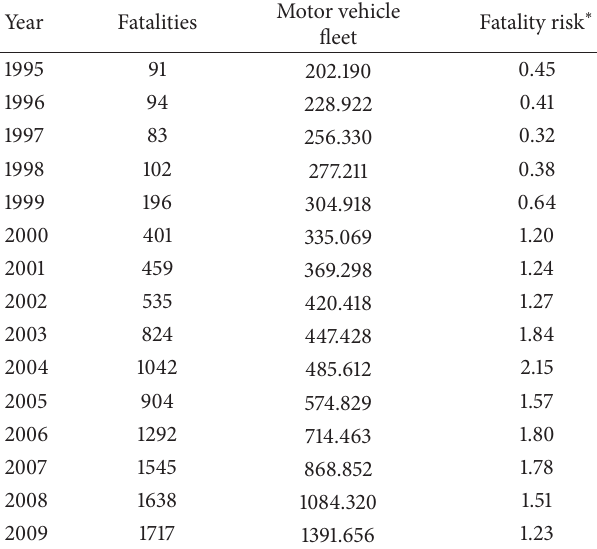
Table 1: Observed numbers of fatalities (in absolute numbers), observed numbers of motor vehicles (in thousands), and fatality risk (fatalities per thousand vehicles) in Cambodia for the years